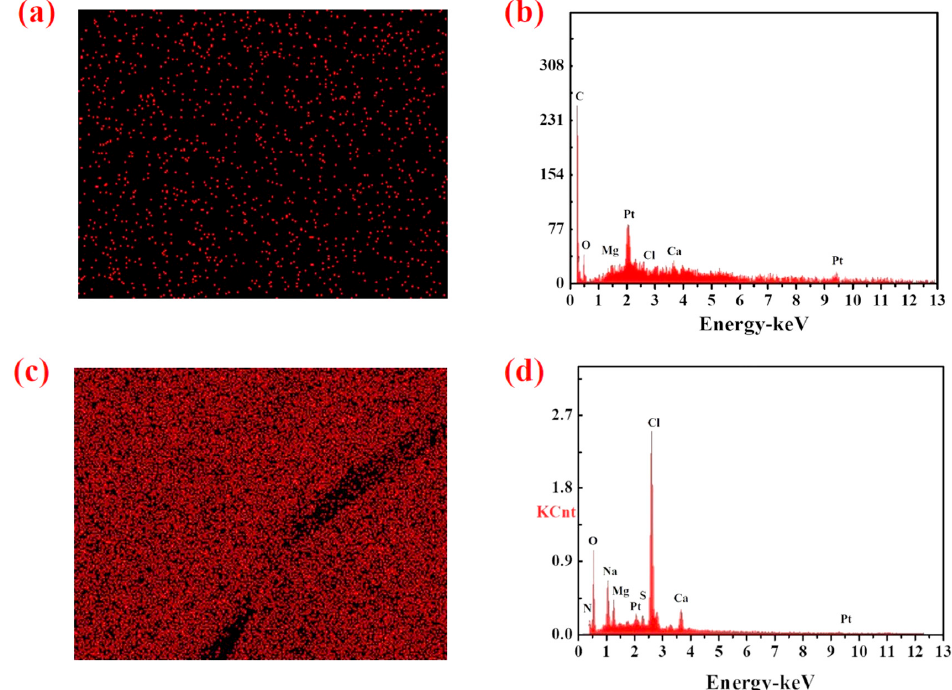
Figure 6. The chloride content and elemental distribution in PAMC gels: ( a , b ) before adsorption; ( c , d ) after adsorption in seawater.